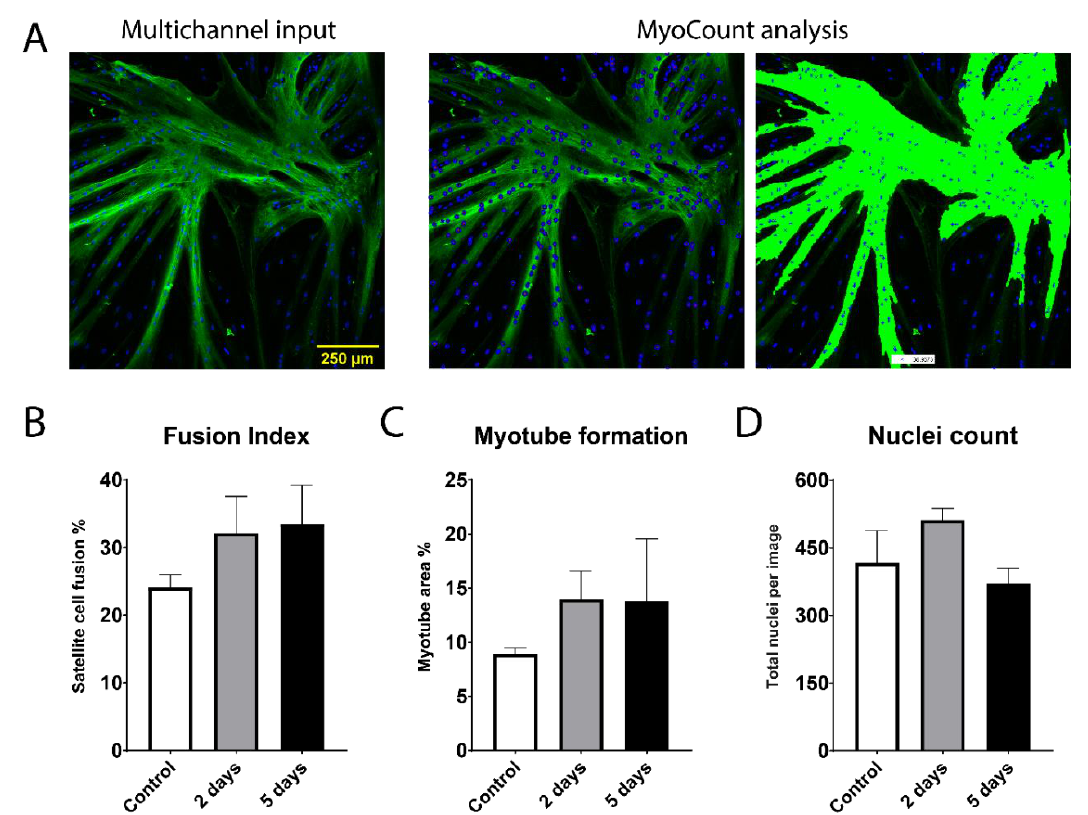
Figure 3. Satellite cell fusion and formation of MHC-positive myotubes. ( A ) Multichannel fluorescence images of myosin heavy chain (MHC) (green channel) and Hoechst-stained nuclei (blue channel) were overlayed before MyoCount analysis. Fusion index ( B ), myotube formation ( C ) and total nuclei count ( D ) were quantified. The three groups compared are the freshly isolated samples (Control) and the 2 and 5 days of storage isolates. Data is presented as mean ± SEM based on three cows with 2 × 4 images each ( n =3).